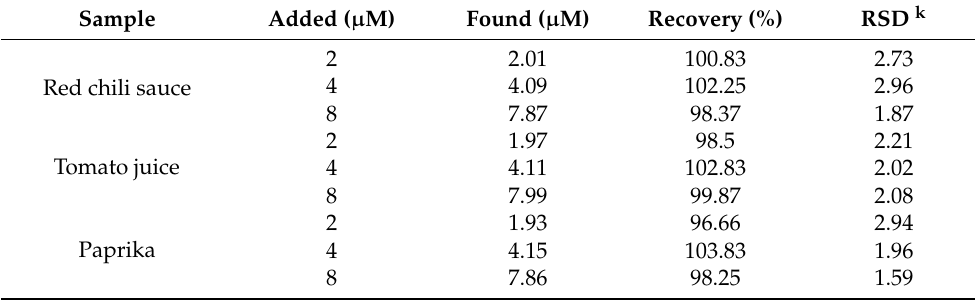
Table 2. Determination of RhB in real samples using proposed sensor.